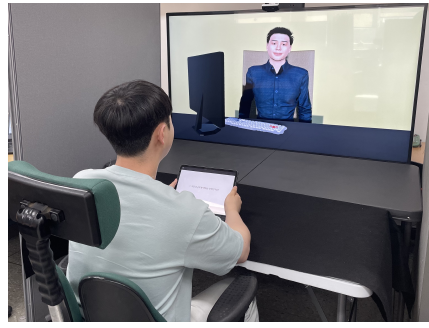
Figure 7. The experimental